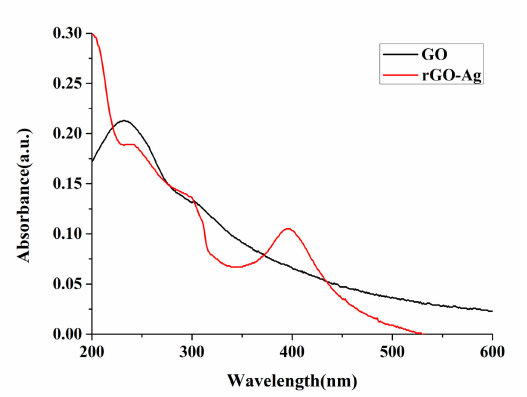
Figure 5. The ultraviolet-visible spectroscopy (UV-Vis)